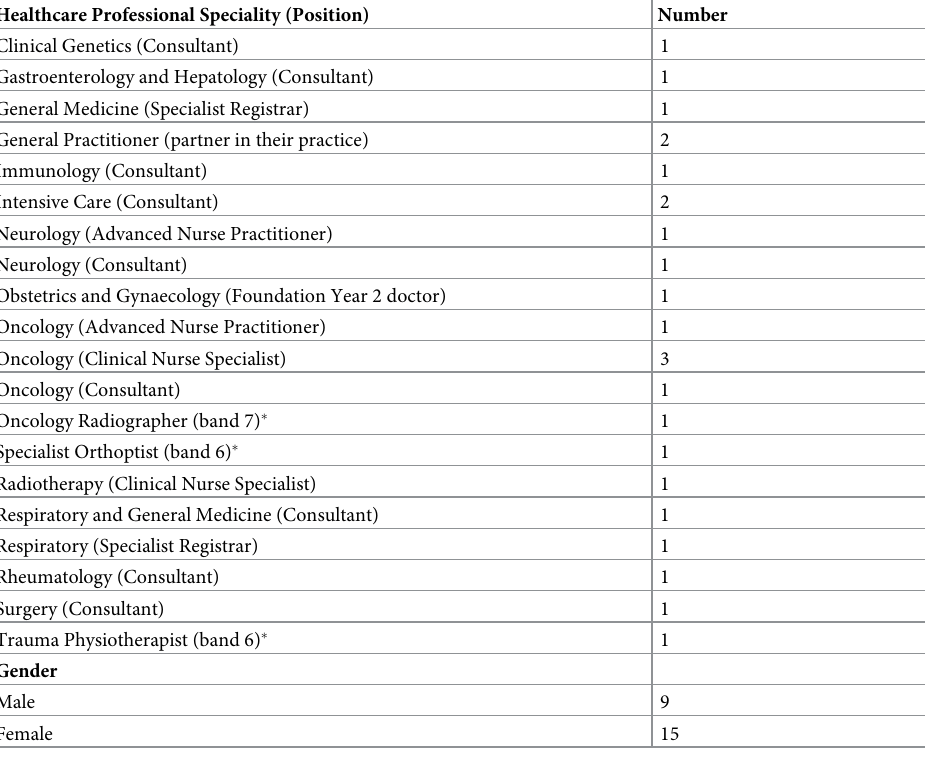
Table 2. Characteristics of the 24 participants interviewed in the